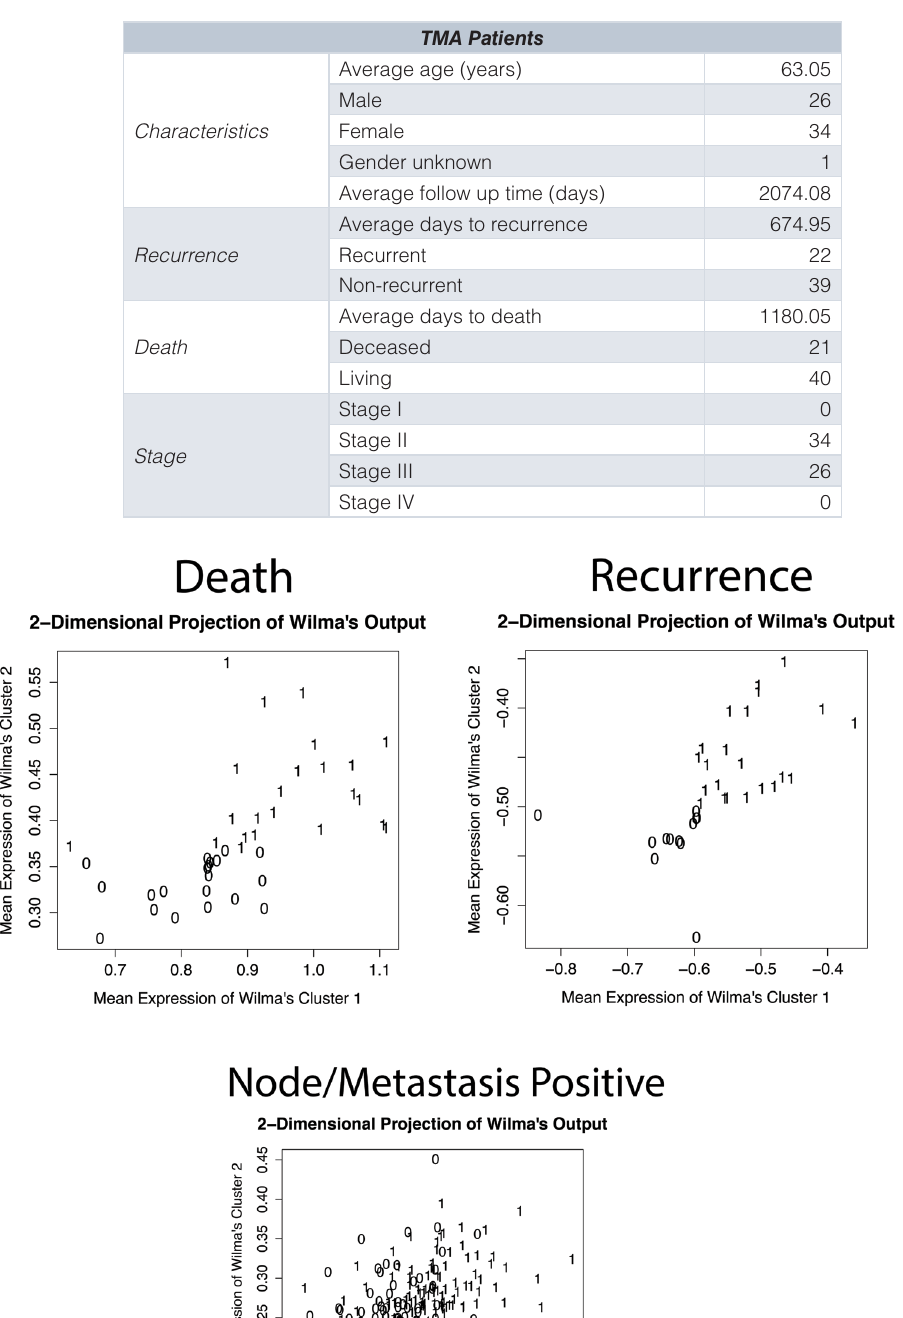
Supplemental Table 5. Characteristics of patients included in TMA analysis.